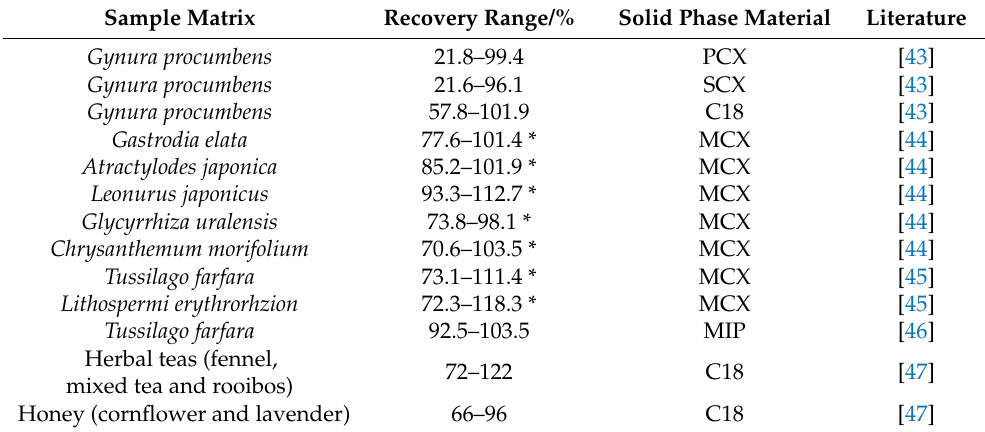
Table 5. Recovery rates of pyrrolizidine alkaloids in different matrix in previously published solid phase extraction